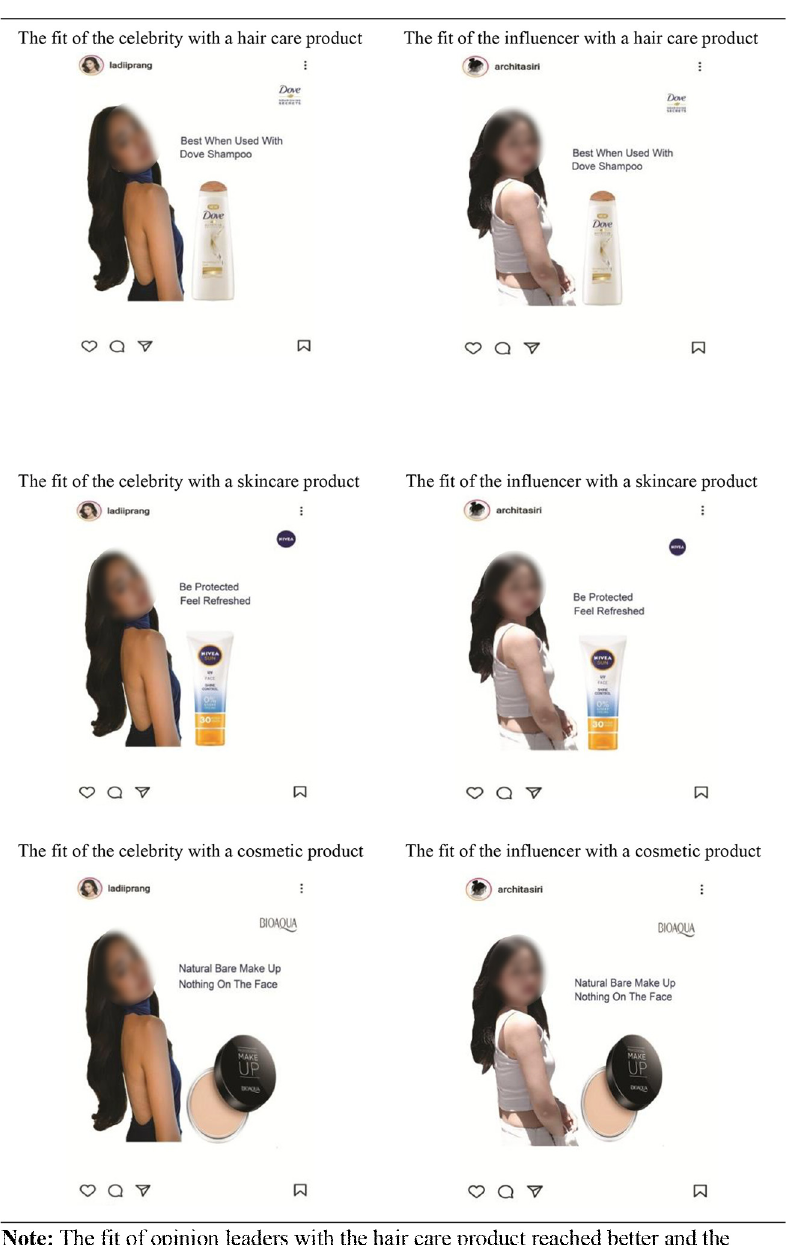
Figure 2. The six manipulated fi t